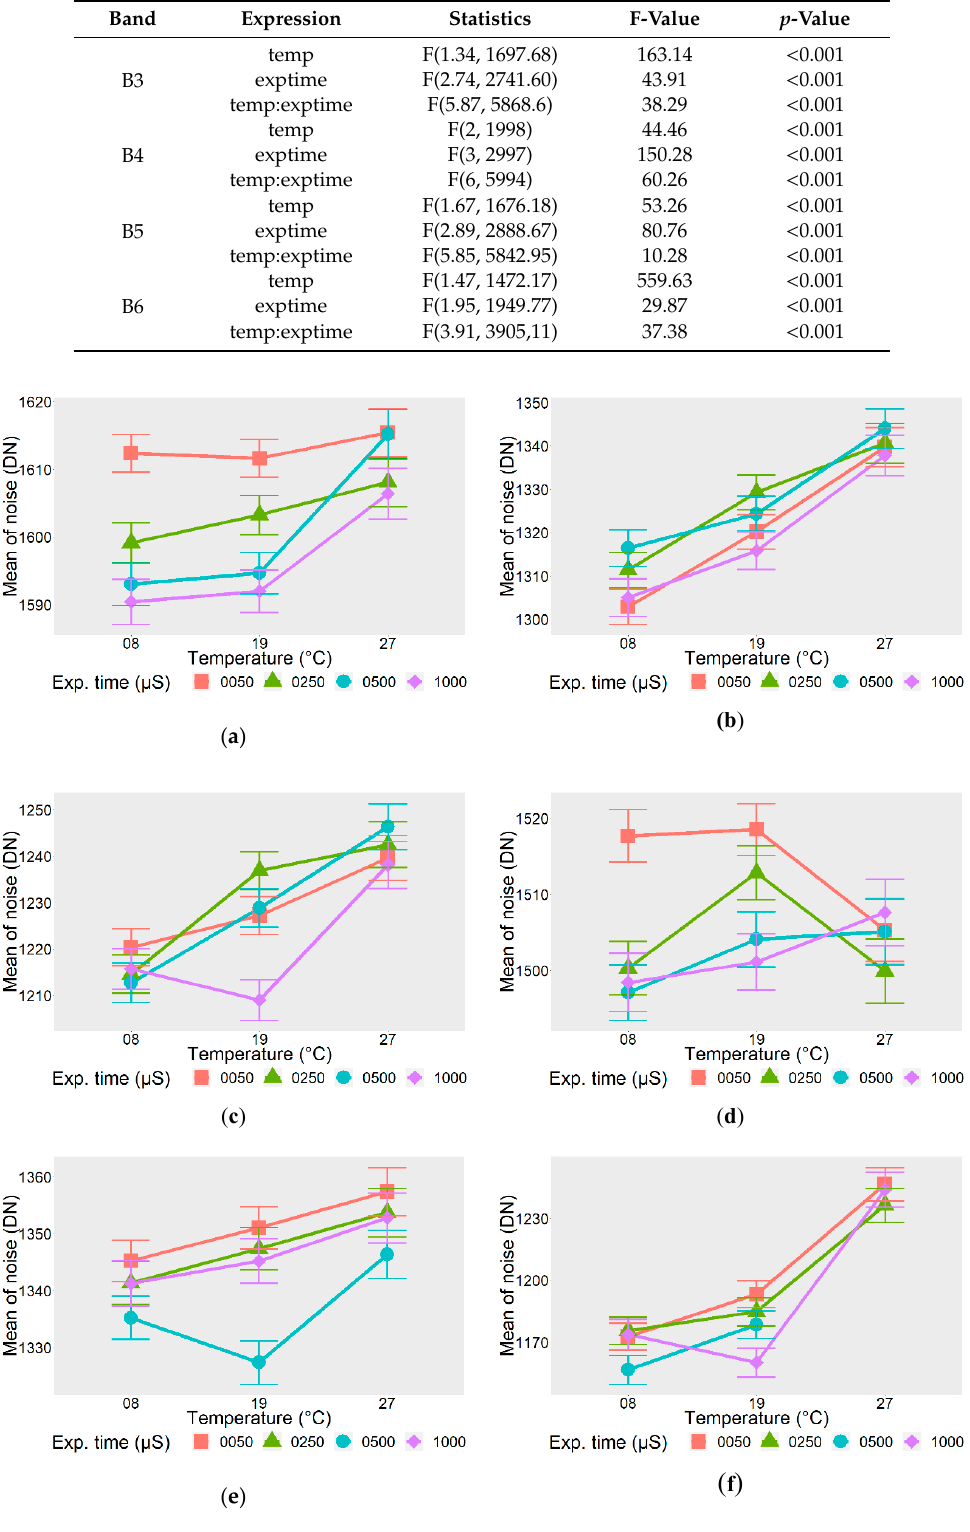
Figure 13. The interaction plot of model term temp:exptime for each band: ( a ) Band 1; ( b ) Band 2; ( c ) Band 3; ( d ) Band 4; ( e ) Band 5; ( f ) Band 6. Error bars represent 95% confidence